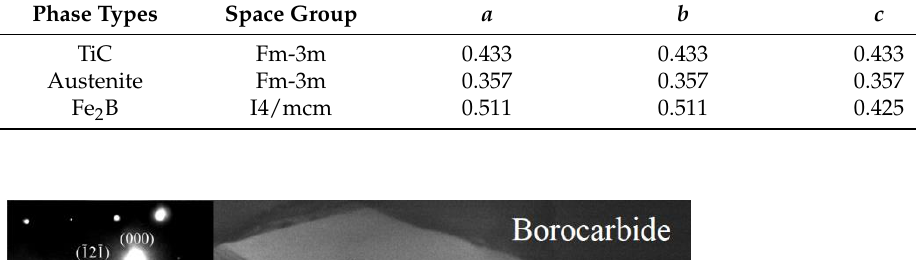
Figure 9. Lattice structure of TiC ( a ), austenite ( b ), and boride Fe 2 B ( c ). Table 5. Lattice parameter of TiC, austenite, and boride Fe 2 B (nm).